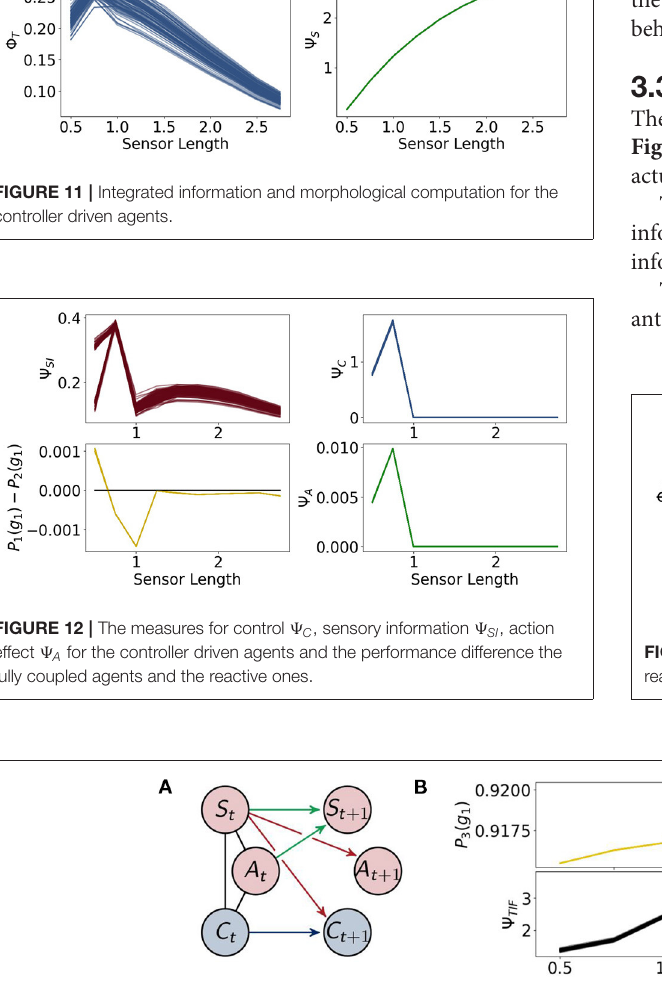
Frontiers in Psychology |